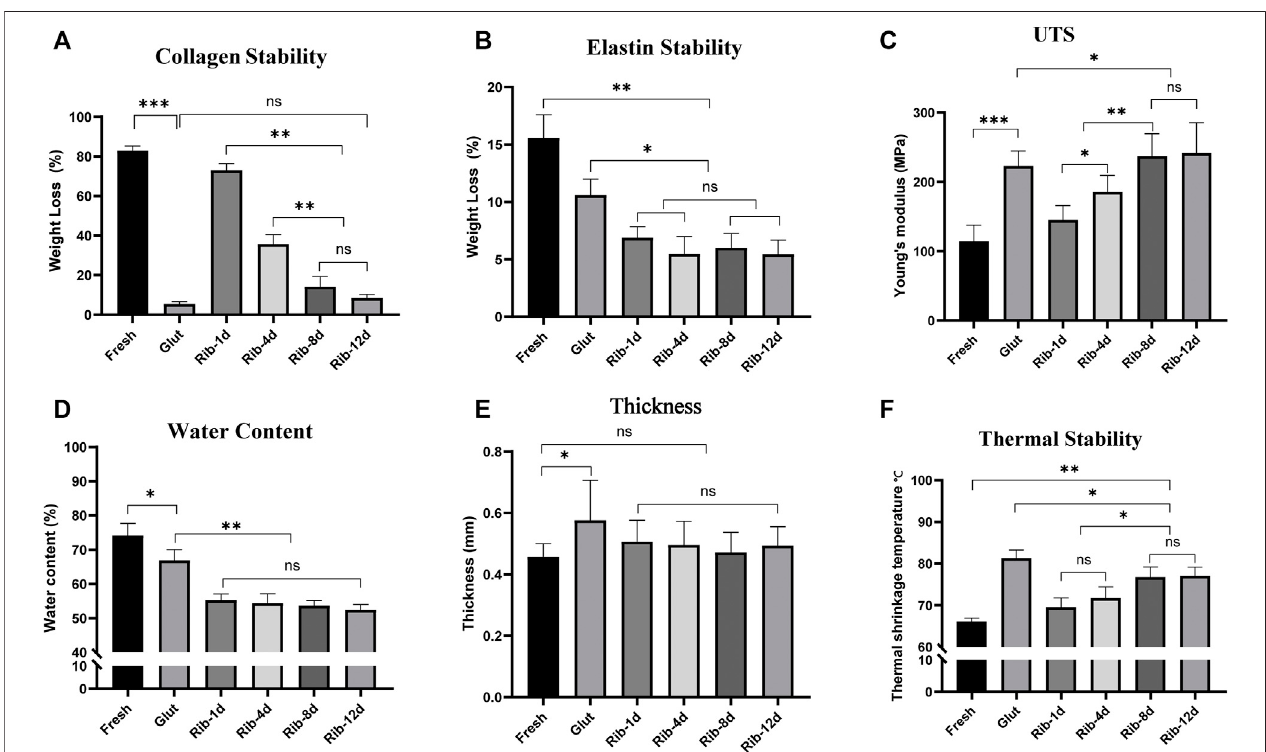
FIGURE 8 | ECM stability of the BP in vitro study. (A,B) Relative weight loss of the BP ( n = 6) after 24 h collagenase and 48 h elastase digestion. (C) Young ’ s modulusoftheBP( n =12)inuniaxialtensiletesting. (D) WatercontentoftheBP( n =4). (E) ThicknessoftheBP( n =12). (F) ThermalshrinkagetemperatureoftheBP( n = 6) (* p < 0.05, ** p < 0.01, and *** p < 0.001; ns represents no signi fi cant difference).